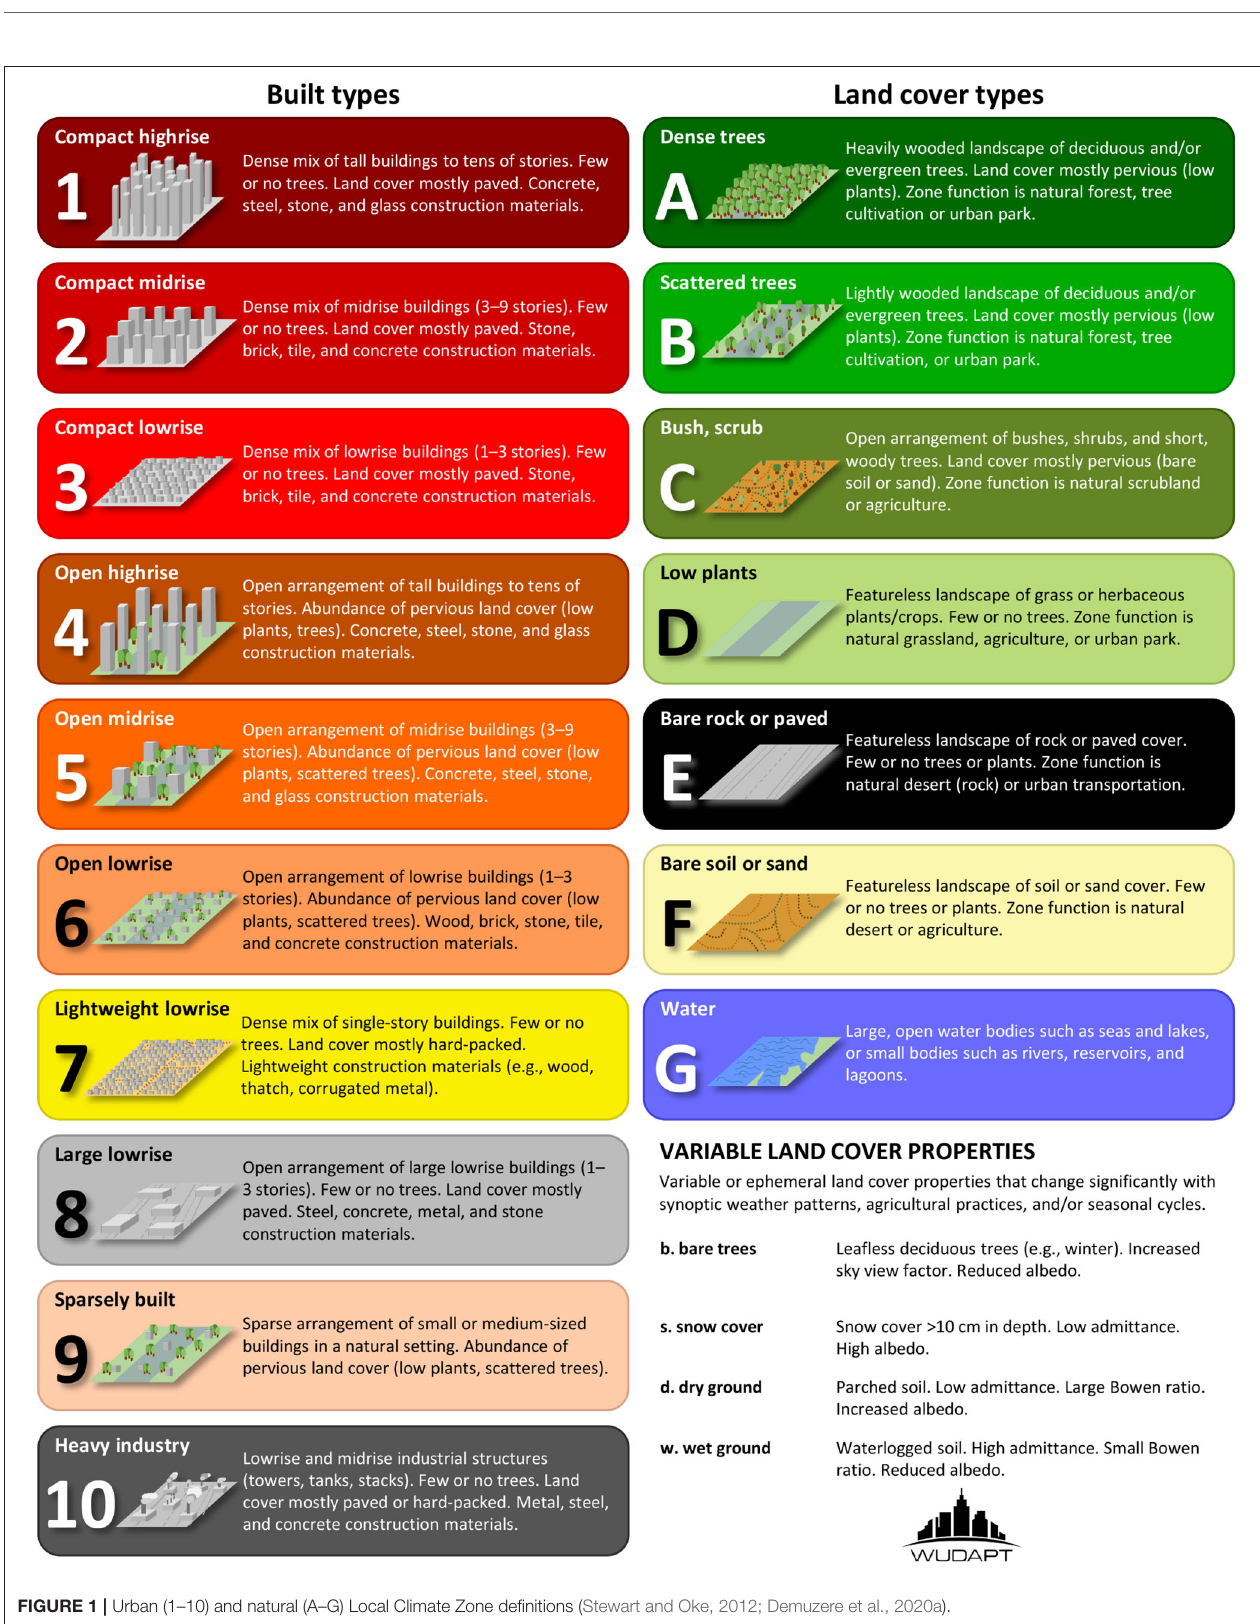
Frontiers in Environmental Science |